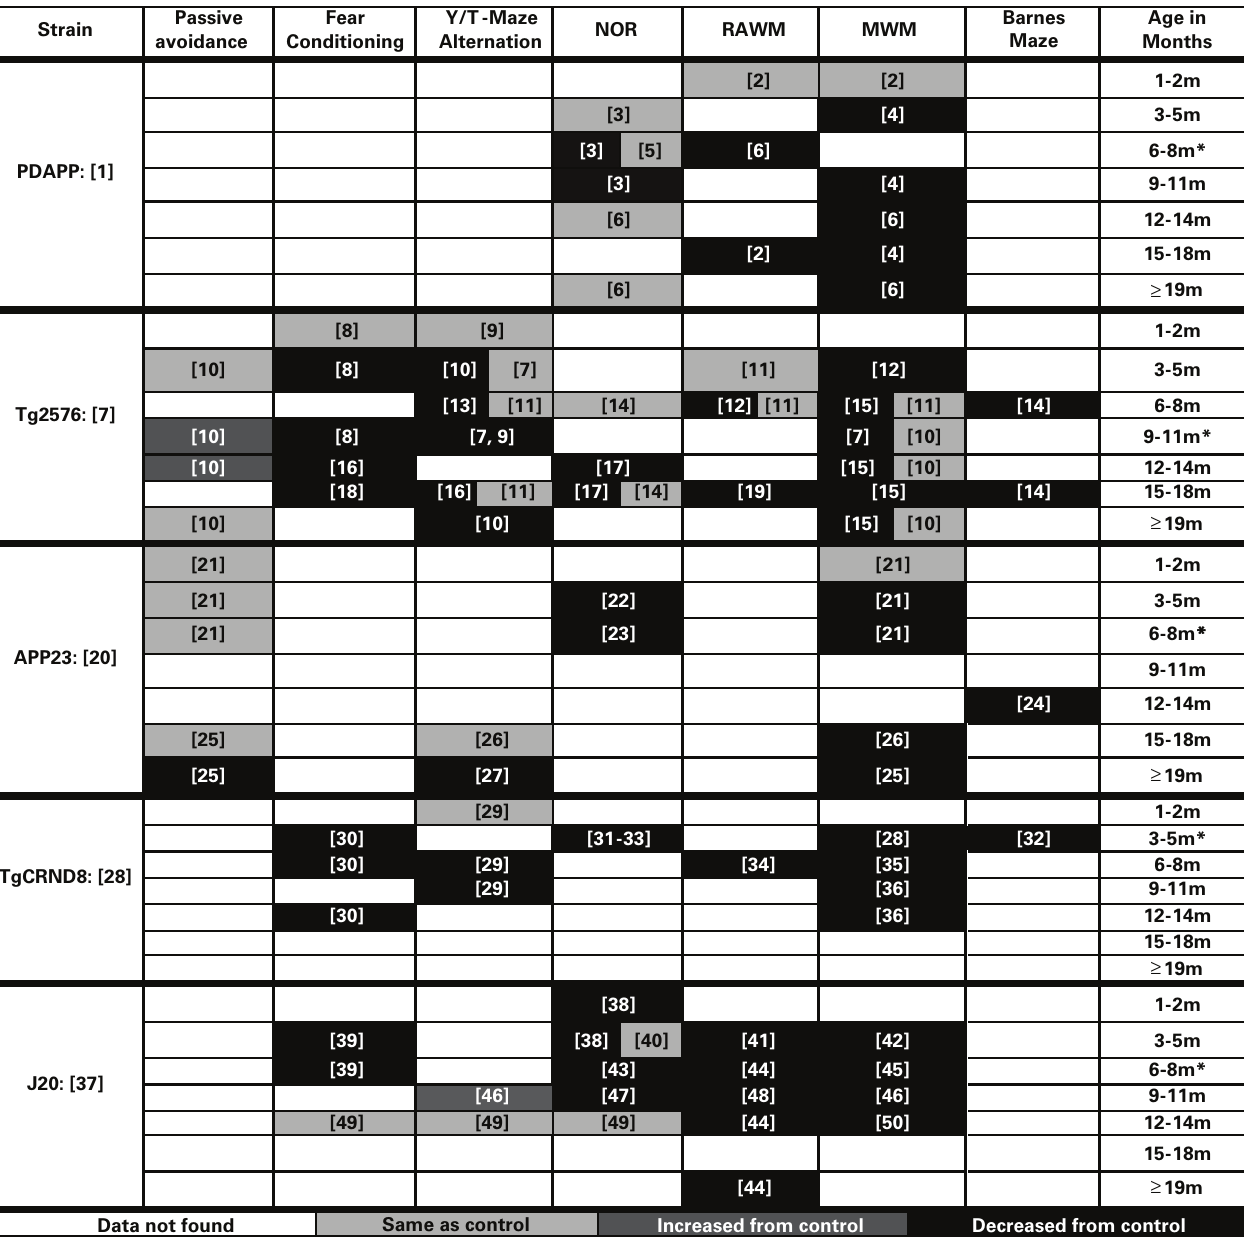
Table 3 | Progression of cognitive deficits in APP mouse models of AD. Strain